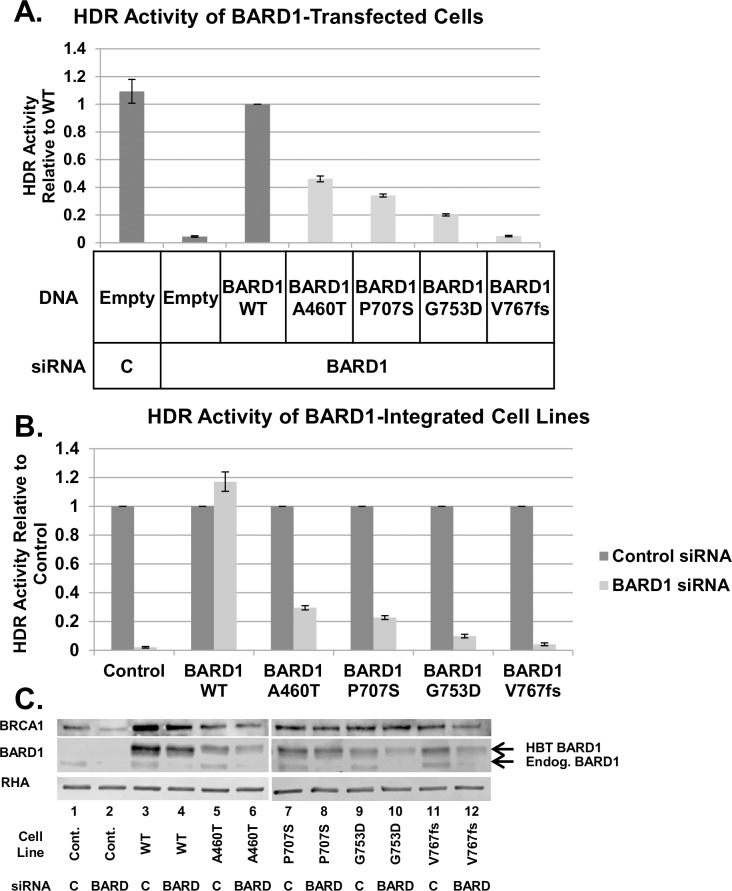
HBT-tagged BARD1 variants expressed from a single FRT site function similarly to transiently transfected variants in HDR.(A) Of the 76 BARD1 variants examined for HDR functionality (Fig 2A), BARD1 A460T, P707S, G753D, and V767fs were selected for further study based on their range of HDR activity. (B) BARD1 variants integrated into a single FRT site in HeLa-DR-FRT/TR cells [29] functioned similarly to the same variants expressed in HeLa-DR cells by transient transfection. HBT-tagged BARD1 WT and variants were integrated into HeLa-DR-FRT/TR cells via the FRT site for consistent single-site expression. Cells were treated with control or BARD1 3'UTR siRNA and examined via the HDR assay. Unintegrated HeLa-DR-FRT/TR cells were used as a control. For comparison, results from transiently transfected cells were selected from Fig 2 (Fig 3A), and the results from expressing the integrated BARD1 variants are shown. While HDR activity was lower in cells containing integrated BARD1 as compared with transiently expressed BARD1, the integrated variants exhibited the same trend as the transiently expressed variants—BARD1 A460T was the most proficient, followed by BARD1 P707S, G753D, and V767fs. (C) Endogenous BARD1 was knocked down in treated stable cell lines, and BRCA1 and BARD1 expression were examined. HBT-tagged BARD1 variants migrated more slowly on electrophoresis gels than endogenous BARD1, as indicated by the upper (HBT-tagged) and lower (endogenous) arrows. HBT BARD1 was unaffected by the 3'UTR-targeted siRNA, while endogenous BARD1 was depleted. All of the BARD1 variants expressed at higher levels than the endogenously expressed BARD1 (middle). BRCA1 protein levels were not affected in variant-integrated cells (top).